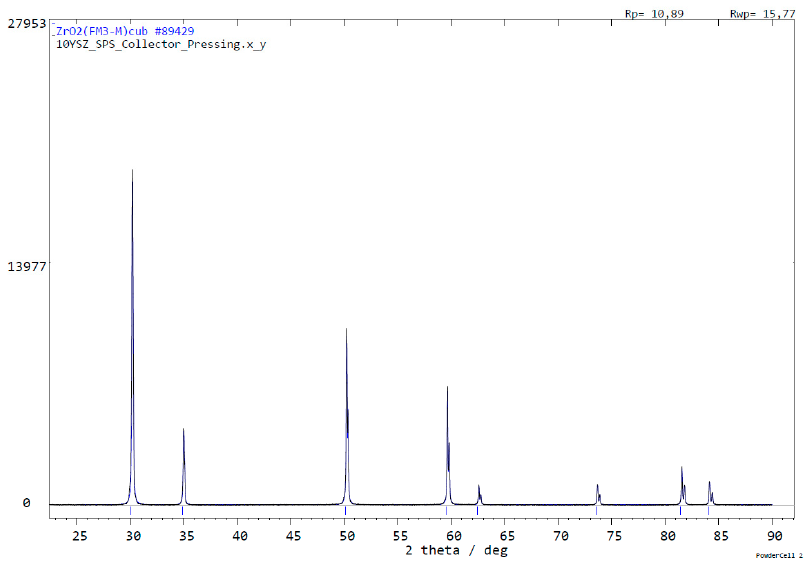
Table 2. Parameters of the crystal structure and microhardness of YSZ ceramics.